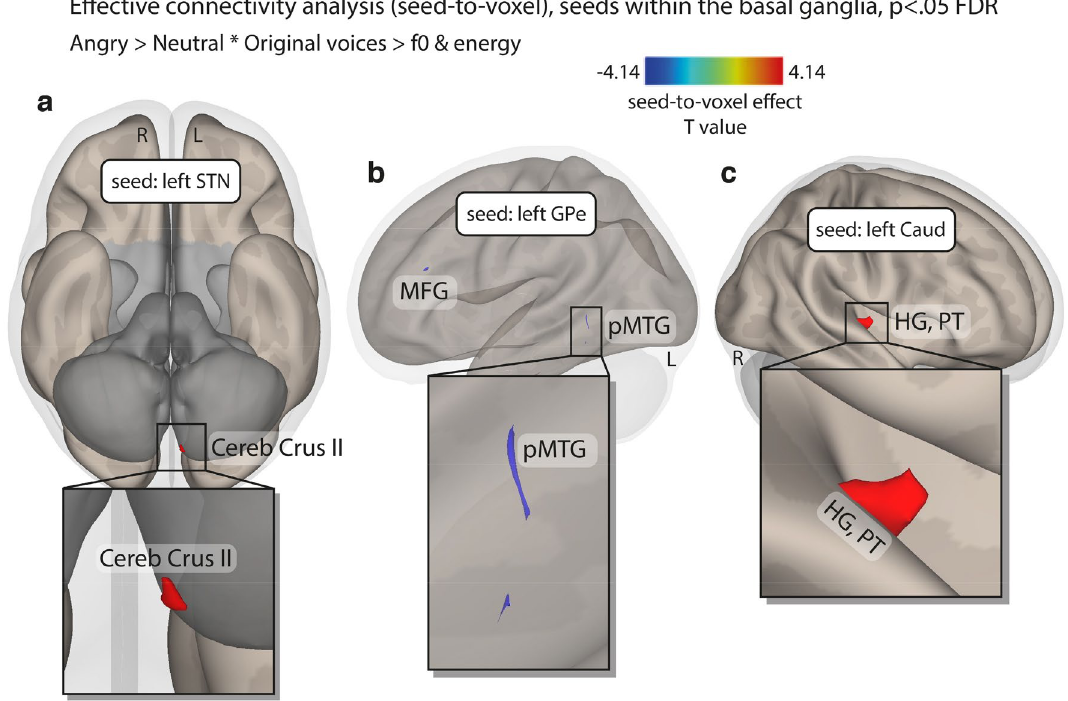
Figure 5. Coupled and anti-coupled seed-to-voxel, gPPI effective connectivity for the interaction between the Emotion and the Acoustic parameter factors contrasting angry > neutral voices * original > f 0 & energy synthesized voices, corrected for multiple comparisons ( p < .05 FDR). ( a ) Inferior view showing direct coupling between the left STN (seed) and the ipsilateral Cerebellum Crus II. ( b ) Sagittal view showing direct anti- coupling between the left GPe (seed) and the left MFG and pMTG. ( c ) Sagittal view showing direct coupling between the left caudate nucleus (seed) and the right primary auditory cortex (Heschl’s gyrus) and planum temporale. L: left; R: right; STN: subthalamic nucleus; GPe: external globus pallidus; Caud: caudate nucleus; Cereb Crus II: cerebellum crus II of ansiform lobule; pMTG: posterior middle temporal gyrus; MFG: middle frontal gyrus; HG: Heschl’s gyrus; PT: planum